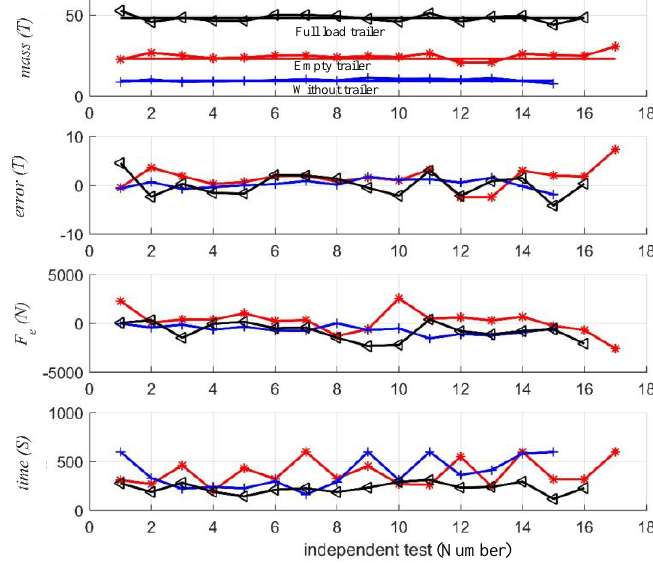
Figure 7. Results of the online estimation.